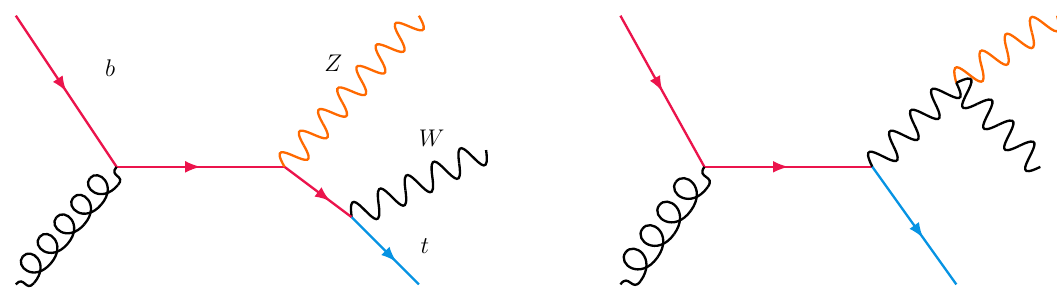
Figure 1 . Representative diagrams for tWZ production in the 5FS at leading order in the gauge couplings. One can think of this process as tW production (featuring two diagrams) with the subsequent Bremsstrahlung of the Z boson from each of the lines (internal or external, except for the gluon) giving rise to a total of eight diagrams.